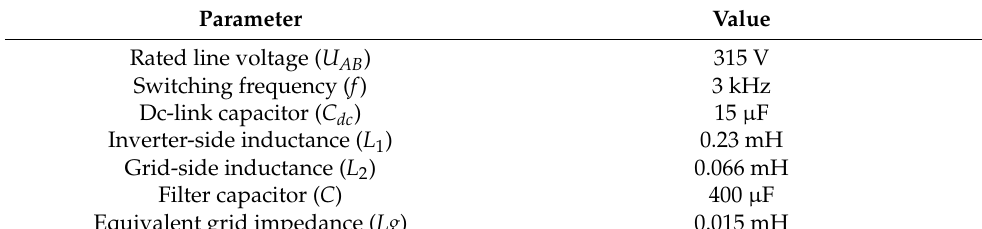
Table 1. Basic parameter of the investigates 500 kW inverter.